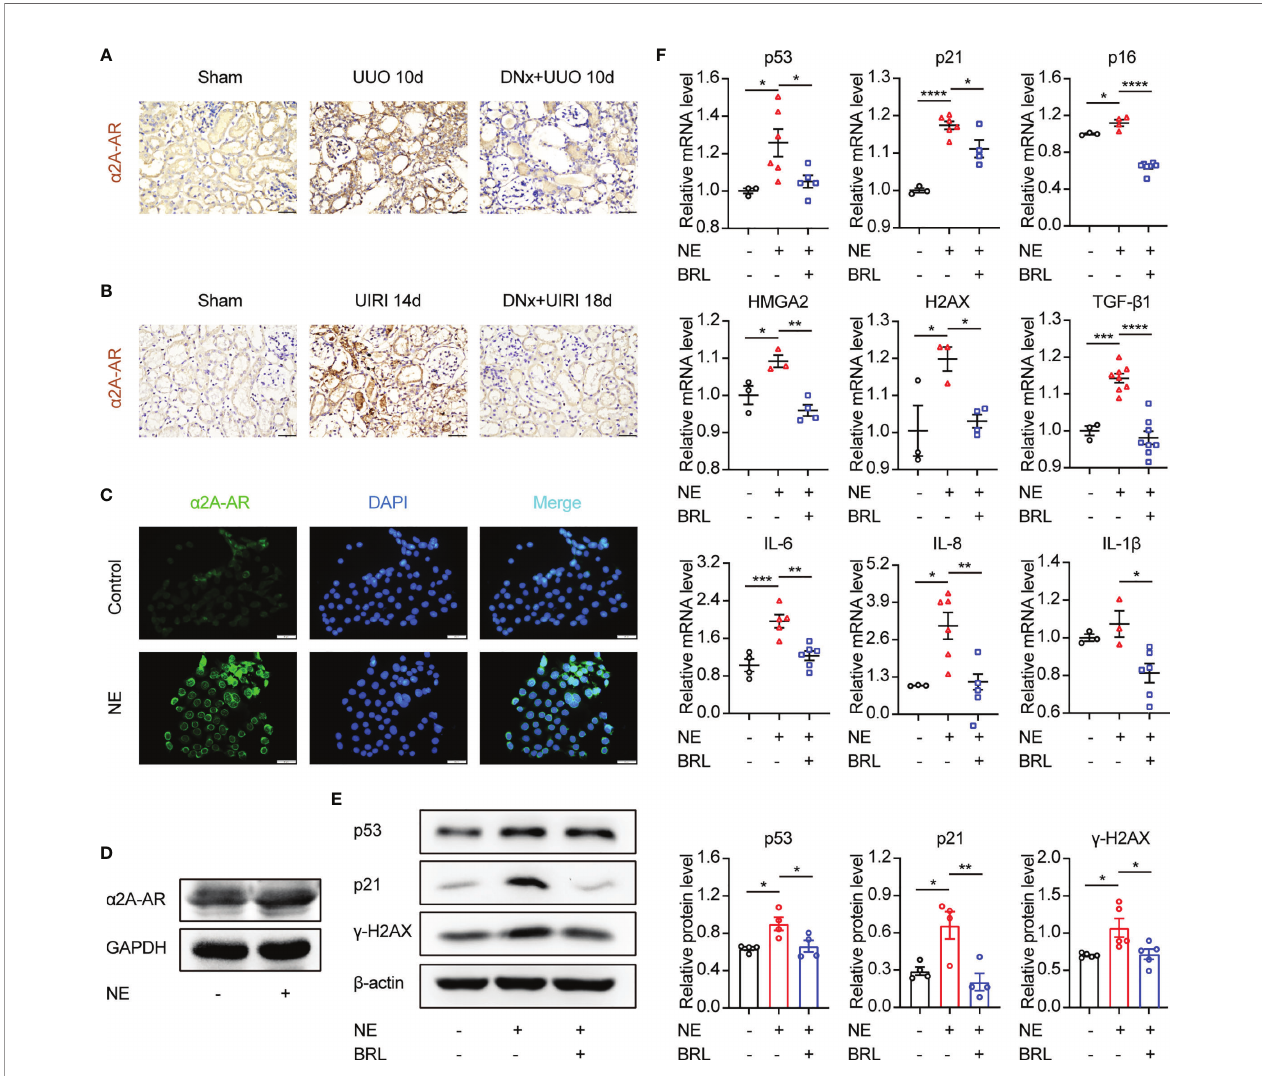
FIGURE 5 | The a 2A -adrenergic receptor is responsible for NE-induced tubular epithelial cell senescence. (A, B) Renal denervation (DNx) or sham operation was performed 2 days before UUO or UIRI in the left kidneys of mice. Representative images of immunohistochemistry for a 2A -adrenergic receptors ( a 2A -AR) in sham- operated, UUO/UIRI, mice and DNx+UUO/UIRI mice. Scale bar, 20 m m. (C, D) After starving for 8 hours, TKPTS cells were cultured with PBS or NE (10 nM) for 48 hours.